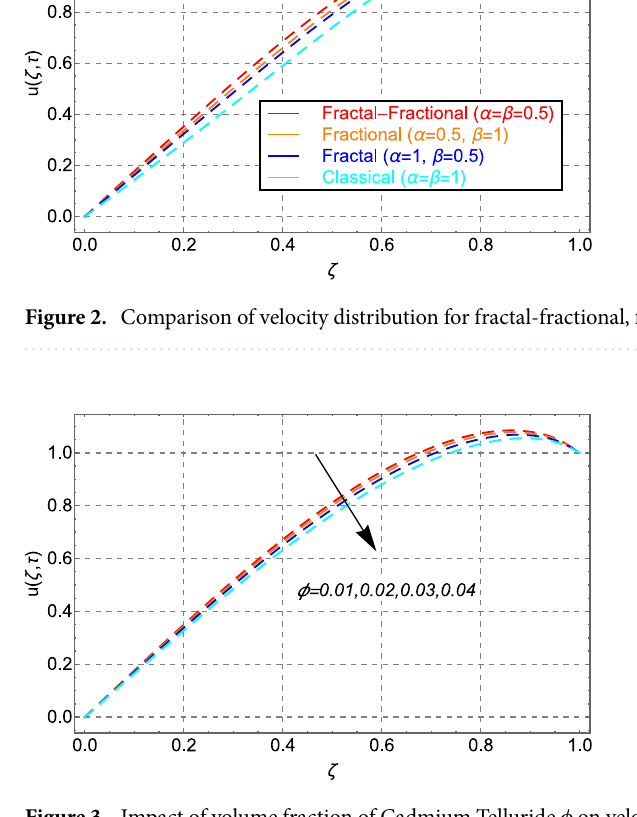
Figure 3. Impact of volume fraction of Cadmium Telluride φ on velocity distribution.